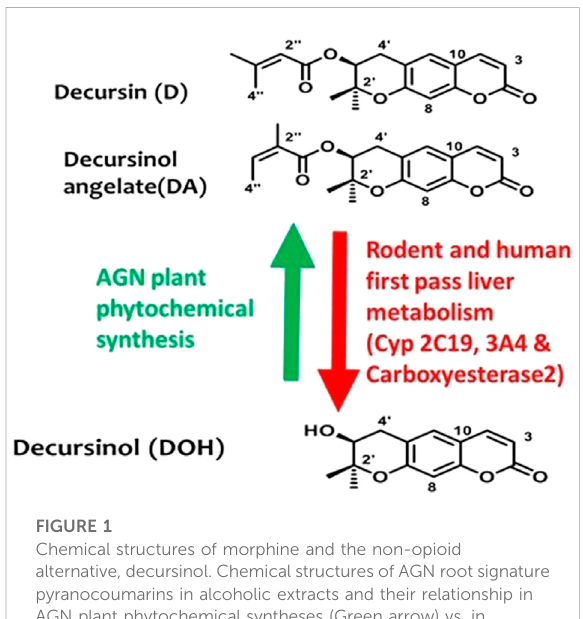
FIGURE 1 Chemical structures of morphine and the